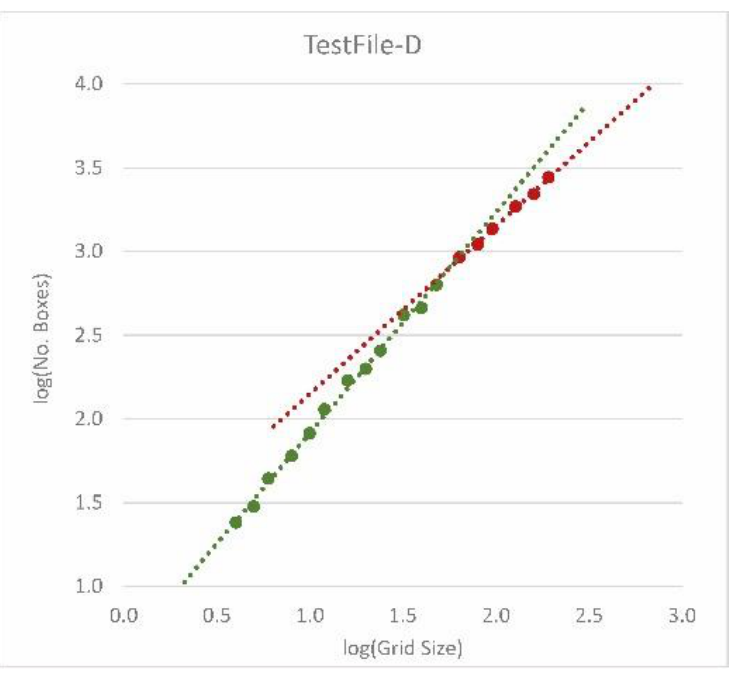
Figure 11. Data curve with the straightest part in green ( 𝐷 𝐵 = 1.3182 and 𝑅 2 =